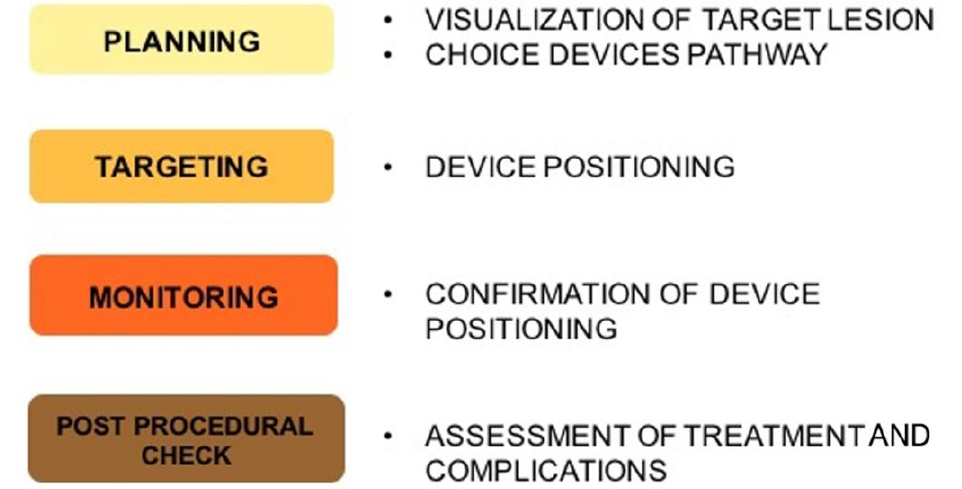
Figure 1. Imaging guidance steps: Imaging is at the core of minimally invasive approach, and selection of the optimal diagnostic and interventional modality is critical for a safe and effective treatment delivery.